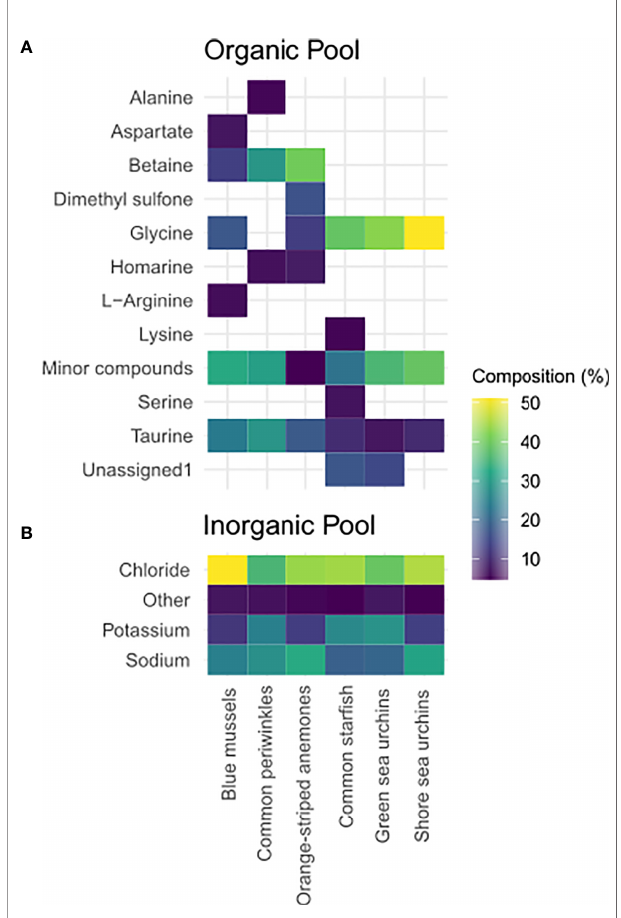
FIGURE 5 | Composition of the total (A) organic and inorganic (B) compound pool in tissues. Depicted are the major compounds (>5%) in tissue extracts of the study organisms at the high salinity treatment: common periwinkles ( L. littorea ), blue mussels ( Mytilus sp.), orange-striped anemones ( D. lineata ), shore sea urchins ( P. milliaris ), green sea urchins ( S. droebachiensis ) and common star fi sh ( A. rubens ). Organic osmolyte data for organge-striped anemones was retrieved from a previous study (Podbielski et al., 2016). The color of the fi eld represents the percentage of the compound in the total pool of measured compounds. If no data is shown for certain species that means that the percentage of this substance is